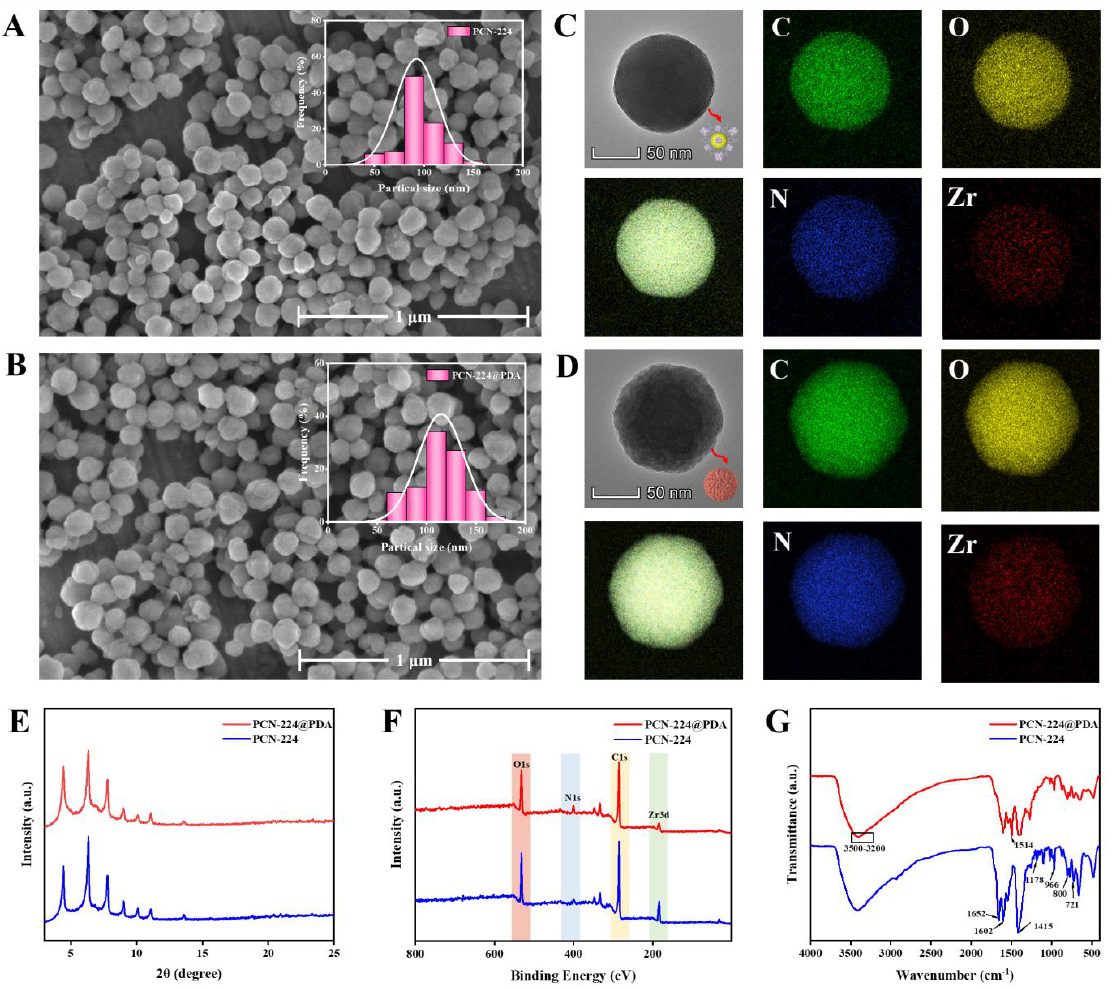
Figure 2. Characterization of PCN-224 and PCN-224@PDA. SEM images of ( A ) PCN-224 and ( B ) PCN-224@PDA, respectively. TEM images and EDS elemental mappings of ( C ) PCN-224 and ( D ) PCN-224@PDA, respectively; ( E – G ) XRD, XPS, and FT-IR spectra of PCN-224 and PCN-224@PDA,